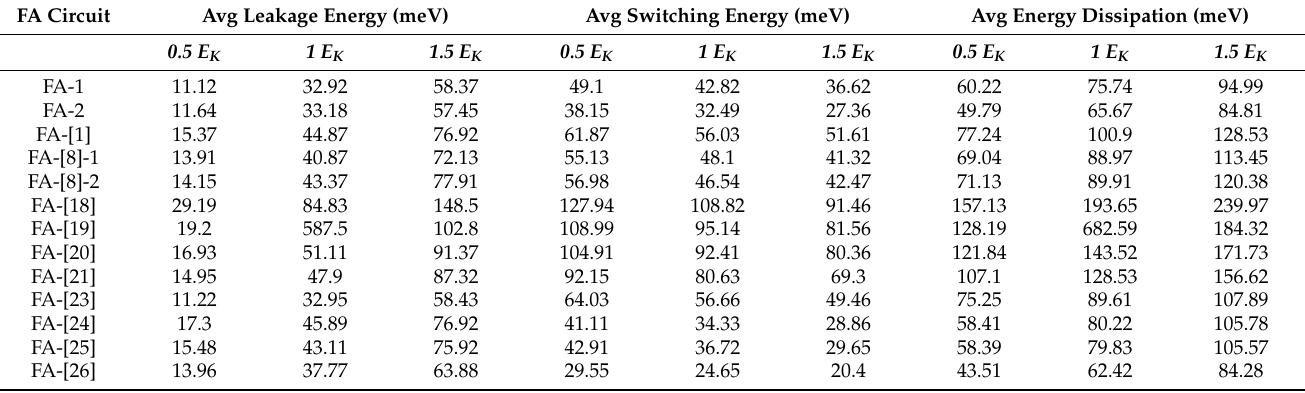
Table 4. Energy consumption analysis of different multipliers at different tunneling energy levels at temperature 2 K